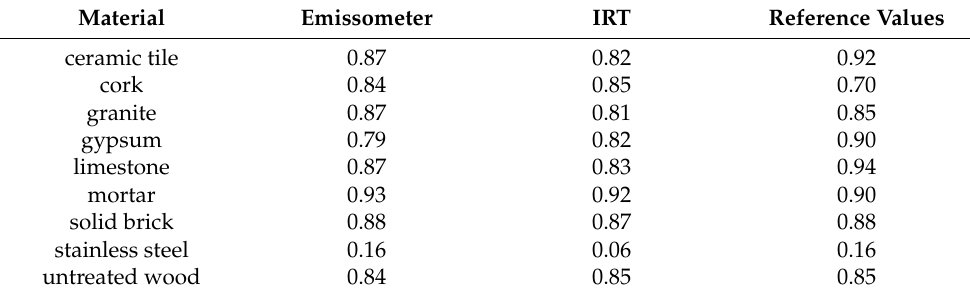
Table 7. Emissivity measured with the emissometer and IRT, and reference values.